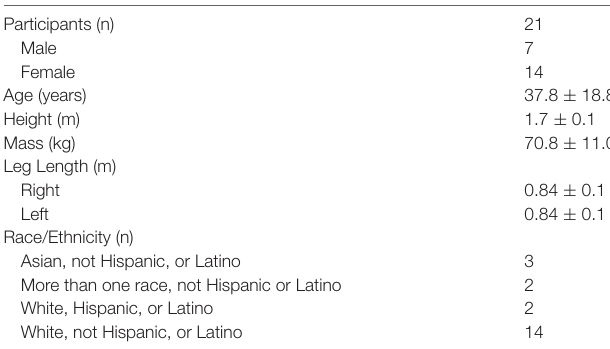
TABLE 1 | Participant characteristics represented as mean ± standard deviation.